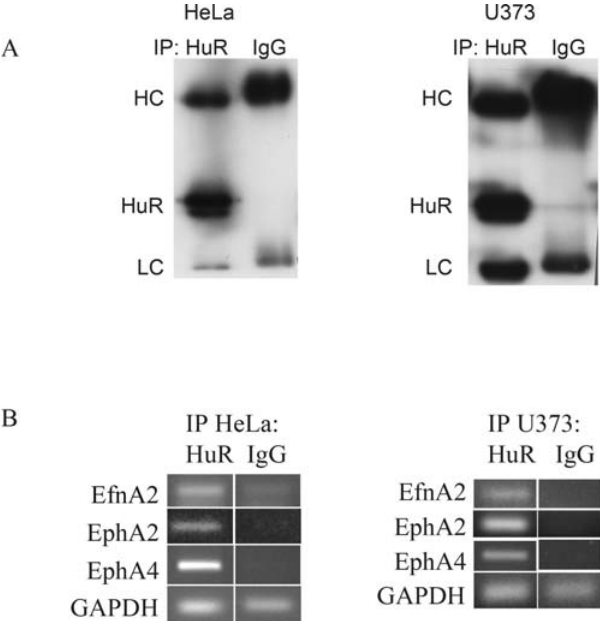
Figure 5. In vivo binding of HuR to Eph/ephrin mRNAs. (A) Immunoprecipitation of endogenous HuR. HeLa or U373 cell lysates were immunoprecipitated with anti-HuR antibody or with unspecific IgGs. Immunoprecipitates were loaded on 10% SDS-Pages and analysed by westernblot with anti-HuR antibody; HC, heavy chain; LC, light chain (B) RT-PCR after RNA-extraction from the HuR and IgG immunoprecip- itates with primers specific for EfnA2, EphA2, EphA4 and GAPDH.